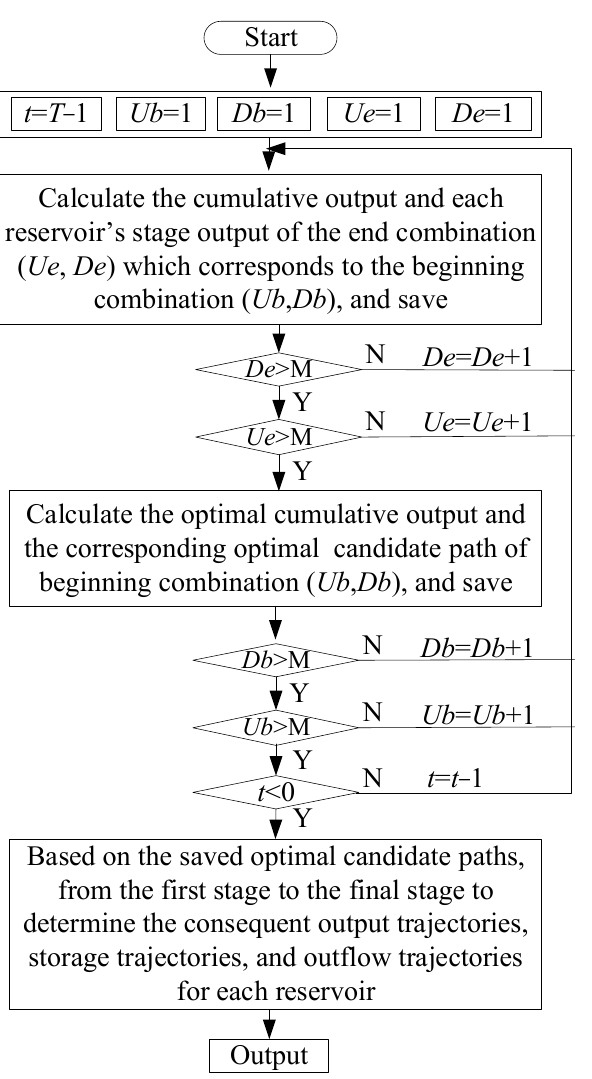
Figure 1. Flowchart of multidimensional DP in solving joint optimal scheduling of cascade reser ‐